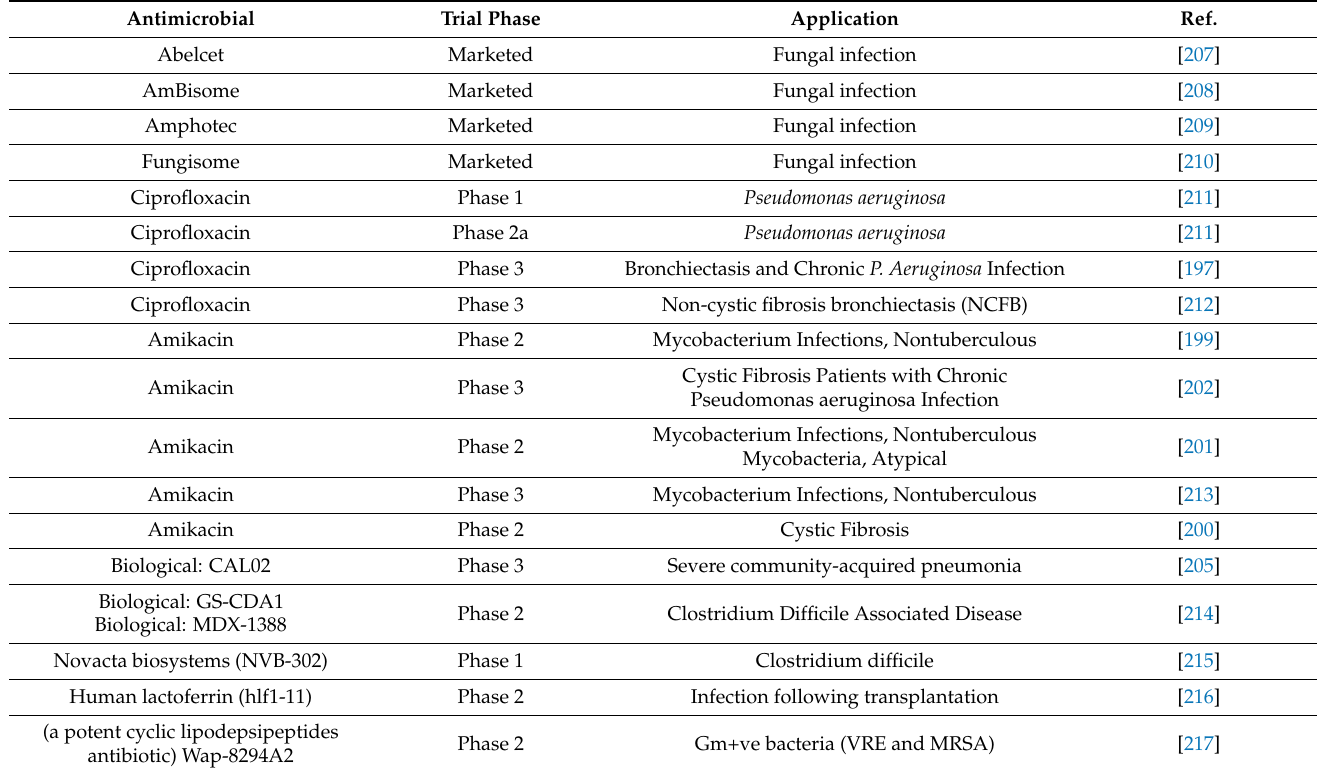
Table 1. Nanomaterial-based antimicrobials in different stages of the clinical trial. Antimicrobial Trial Phase Application